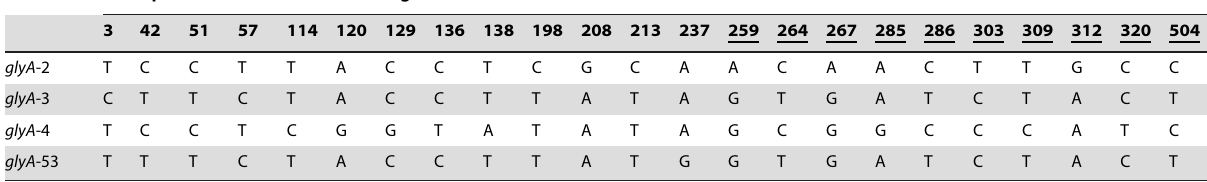
Table 6. SNPs in glyA locus fragments.